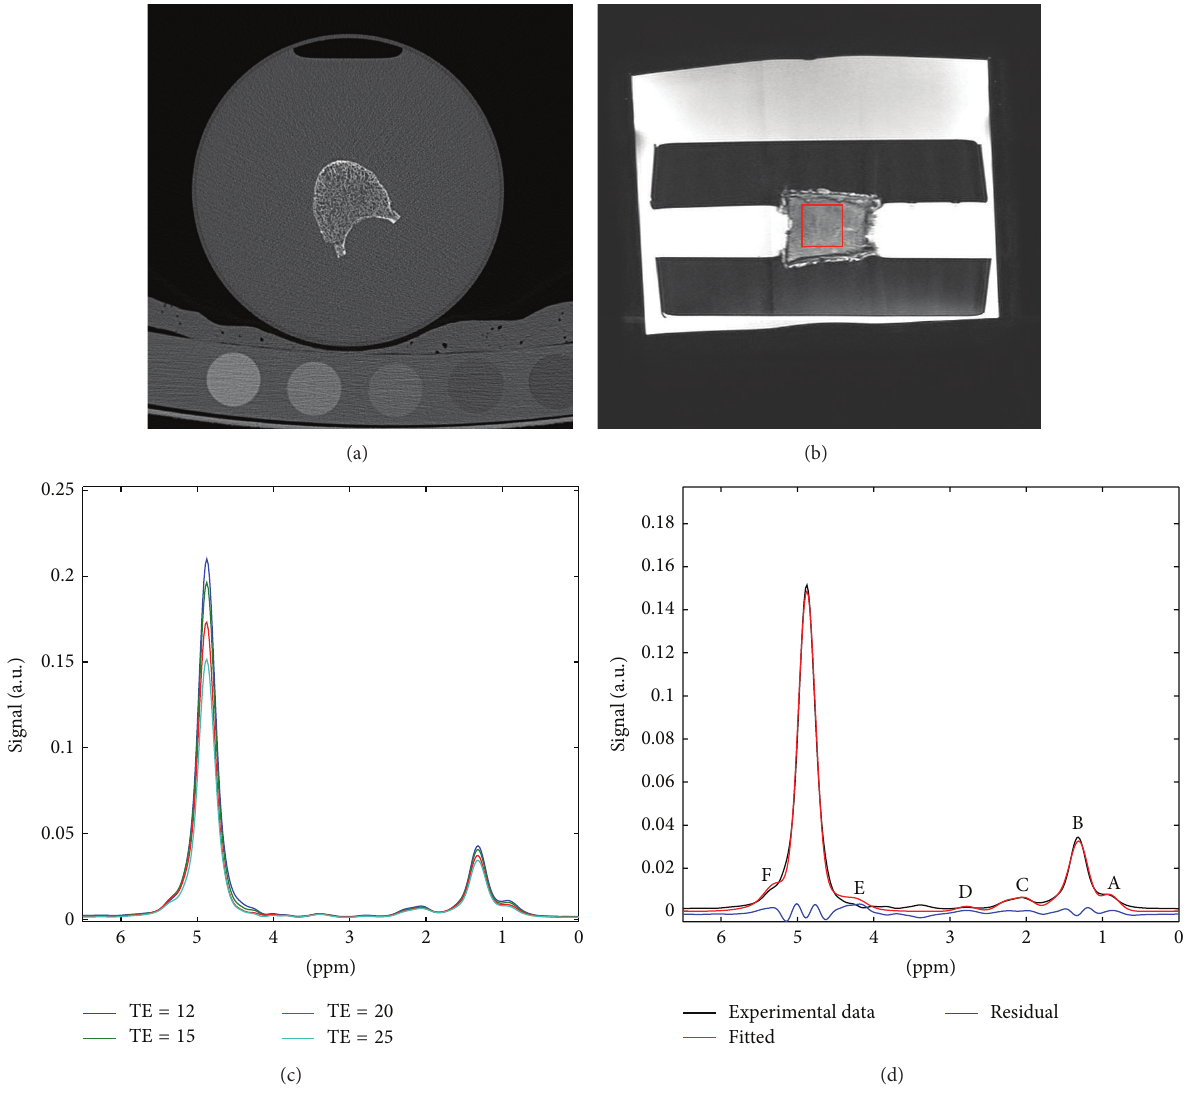
Figure1:Representativeimagesandspectra:(a)MDCTtransverseimageshowingvertebralbodyandcalibrationphantom,(b)sagittalproton density-weighted MR image showing vertebral body and resin holders (the red box within the vertebra corresponds to the voxel position for the employed single-voxel MRS), (c) MR spectrum acquired at different echo times (12, 15, 20, and 25 ms), and (d) quality of spectrum fitting for the MR spectrum at TE = 25 ms (fat peaks A–F labeled along the spectral